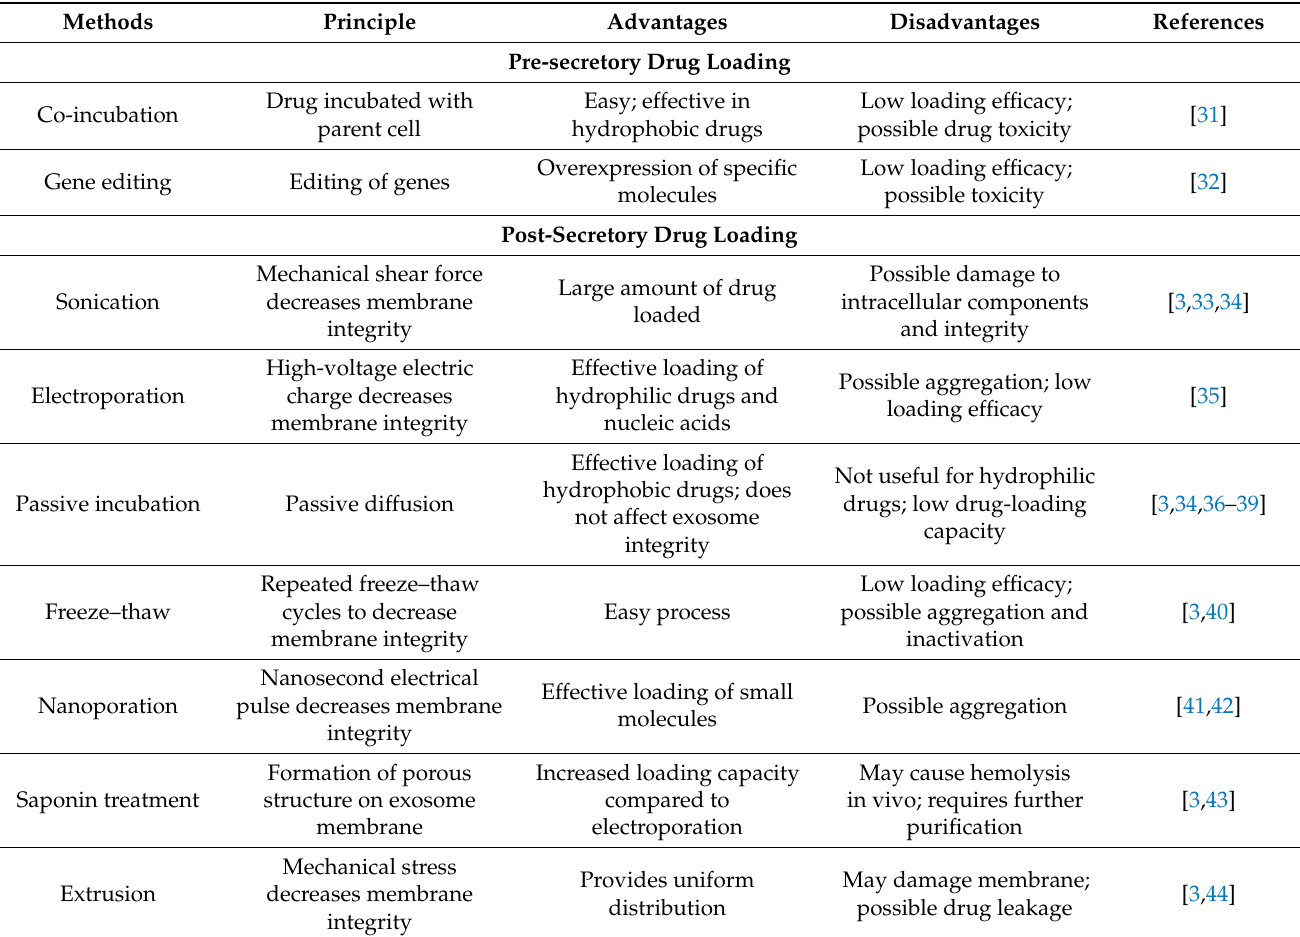
Table 2. A list of the different exosome drug-loading techniques and their advantages and